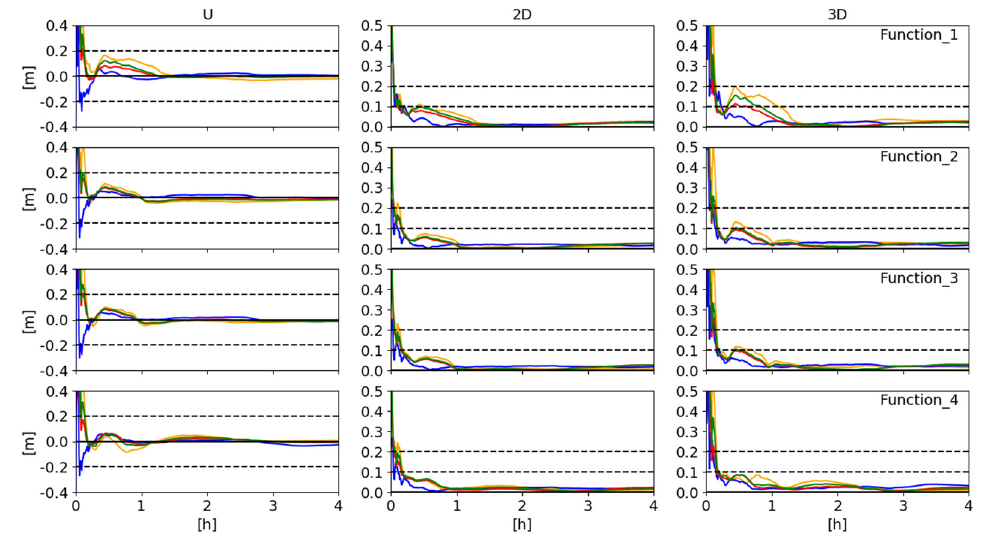
Figure 4. Time series of U component, 2D and 3D errors for the first four hours for the weighting functions. Functions 1 − 4 for the MAS100ESP station for the 39 DoY for all solutions. Blue − E solution, orange − G solution, red − GE solution, green − GE1 solution.